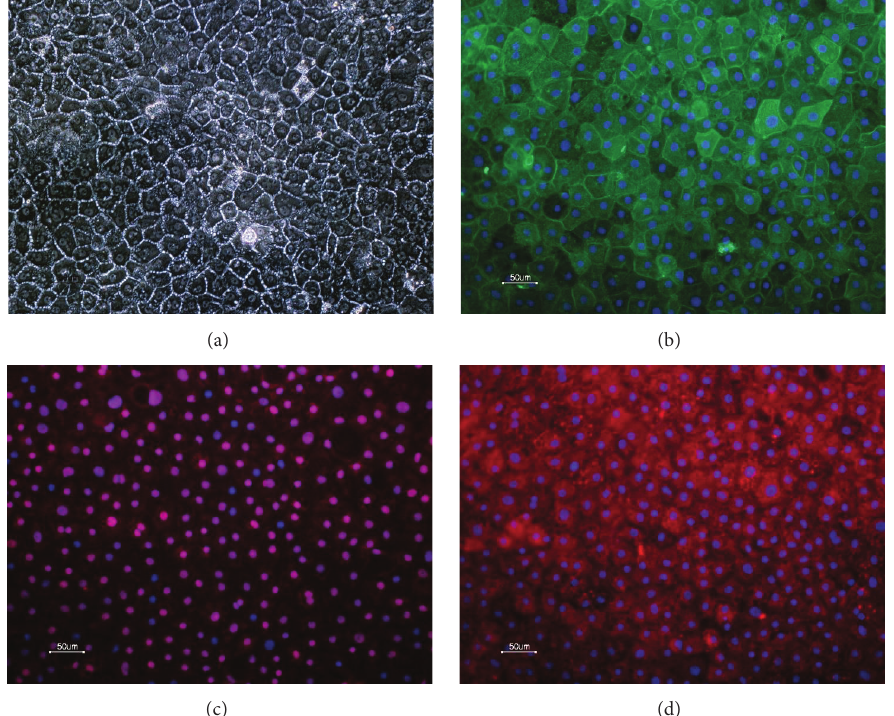
Figure 1: Morphology of hiPSC derived hepatocytes (a) and expression of hepatic markers cytokeratin 18 (b), HNF4 𝛼 (c), and alpha-1- antitrypsin (d). Scale bars equal 50 𝜇